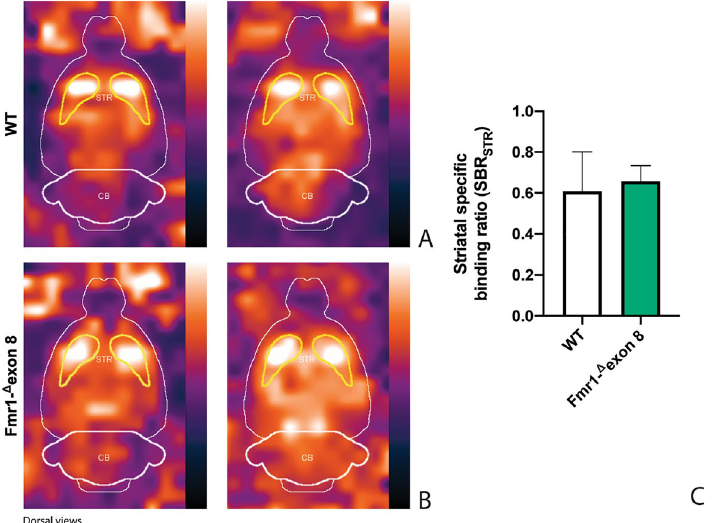
Figure 3. DAT binding. The estimates for the binding potentials were evaluated through the equilibrium ratios of the distribution areas of the specifically (striatum) and non-specifically (cerebellum) bound and striatal specific binding ratios (SBR STR ) for WT and Fmr1- Δ exon 8 rats. ( A ) [ 123 I]FP-CIT binding to striatal DAT in two